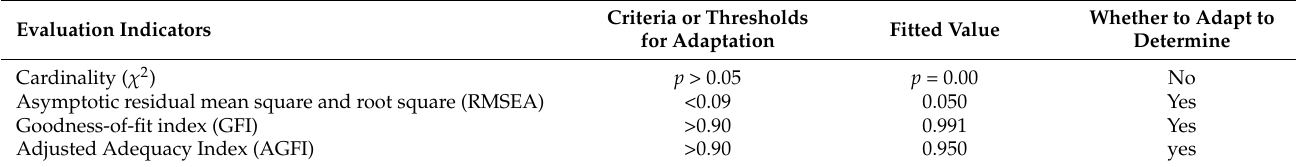
Table 11. Fitted indices of the path analysis model of the property rights development pattern affecting irrigation